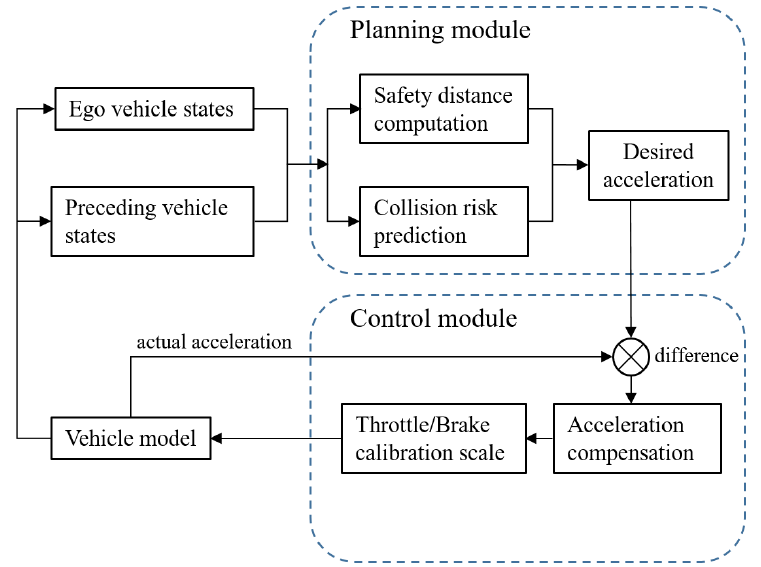
Figure 1. The controlling